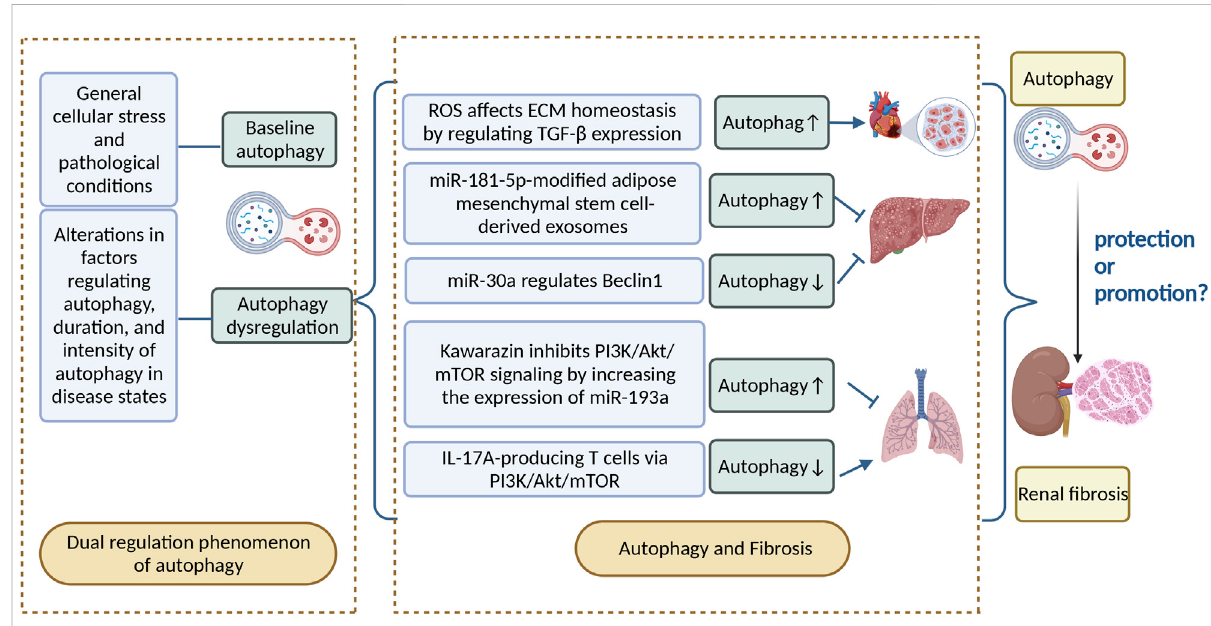
FIGURE 2 Autophagy can be divided into basal autophagy under physiological conditions and induced autophagy under stressful conditions. Autophagy hasabidirectionalregulatoryroleindisease,aswellasin fi broticdiseases,andtherelationshipbetweenautophagyandrenal fi brosisdeservesfurther investigation. ROS, reactive oxygen species; ECM, extracellular matrix; IL-17A,